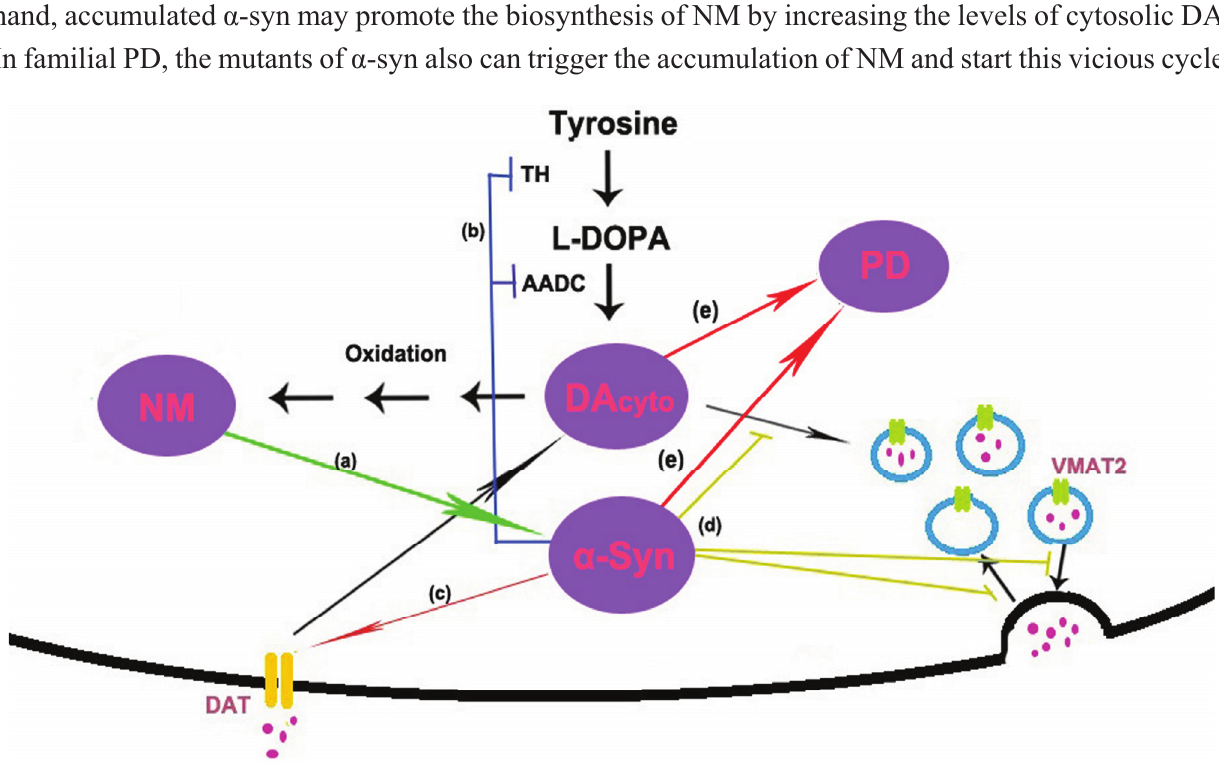
Figure 2. Model of possible interactions between (cid:2)-synuclein ((cid:2)-syn) and neuromelanin (NM). ( a ) NM induces the expression and aggregation of (cid:2)-syn; ( b ) dopamine (DA) is synthesized in the cytoplasm by the action of tyrosine hydroxylase (TH) and amino acid decarboxylase (AADC). (cid:2)-Syn has been shown to regulate the activity of TH and AADC; ( c ) DA is